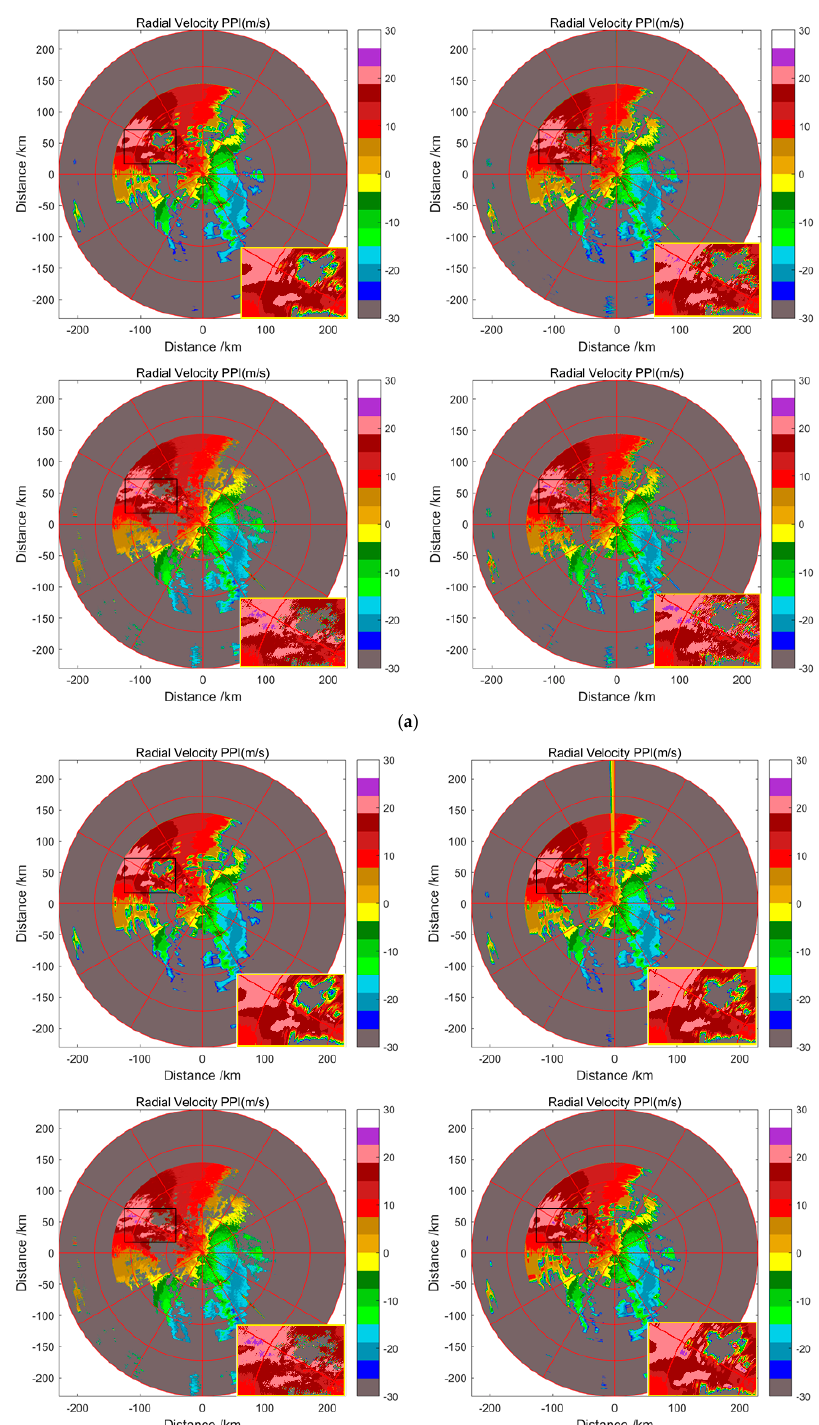
Figure 6. Radar echo reconstruction comparison on radial velocity data. ( a ) 2 × reconstruction of radial velocity data. From left to right and top to bottom: bicubic interpolation echo, the reconstructed echo by IBP [13] (PSNR = 30.0435; SSIM = 0.9184), original radar echo, and the reconstructed echo by the proposed NSSR algorithm (PSNR = 31.1579; SSIM = 0.9253). ( b ) 4 × reconstruction of reflectivity data. From left to right and top to bottom: bicubic interpolation echo, the reconstructed echo by IBP [13] (PSNR = 26.8634; SSIM = 0.8303), original radar echo, and the reconstructed echo by the proposed NSSR algorithm (PSNR = 28.4852; SSIM = 0.8524). The tested data is the second elevation cut of the CINRAD SA radar, which is the same as the data used in Figure